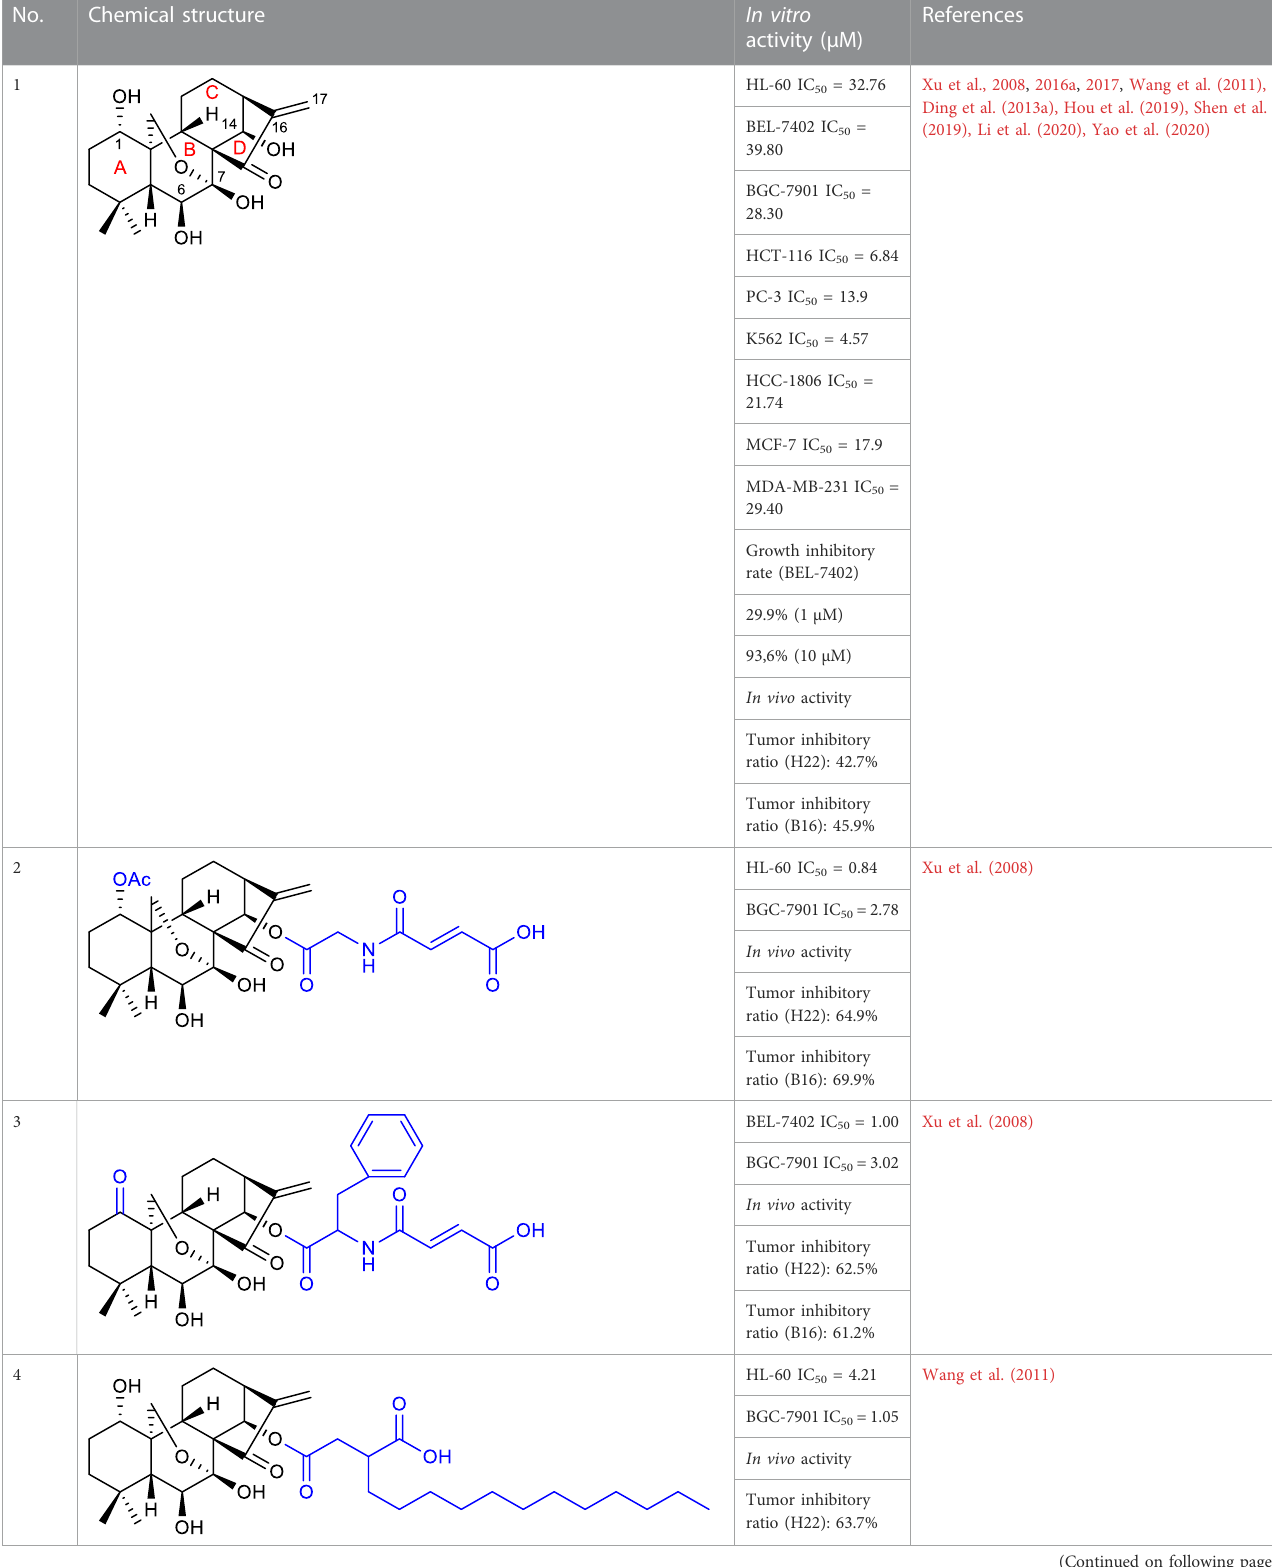
TABLE 1 Recent approaches of oridonin optimizations (modi fi cations of hydroxyl groups).